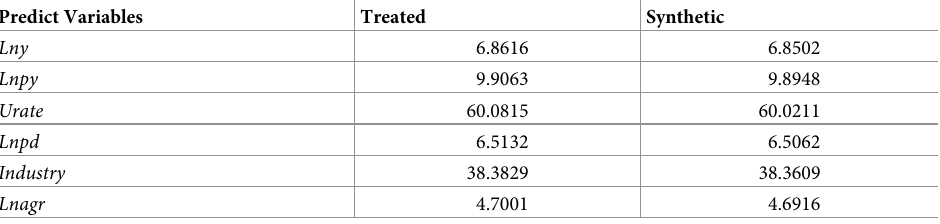
Industry Lnagr Note: “Treated” represents the treatment group, and “Synthetic” represents the synthetic control group.